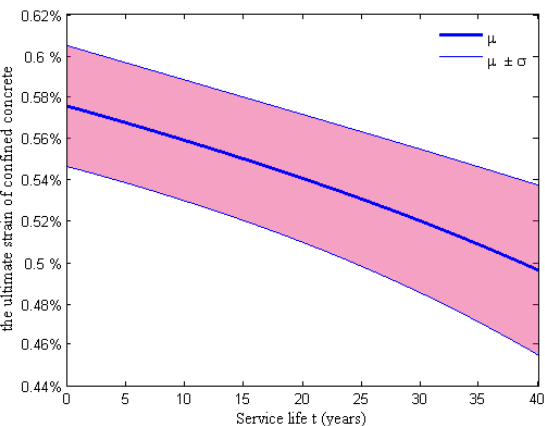
Figure 8. Time-dependence of the ultimate compressive strain of confined concrete.